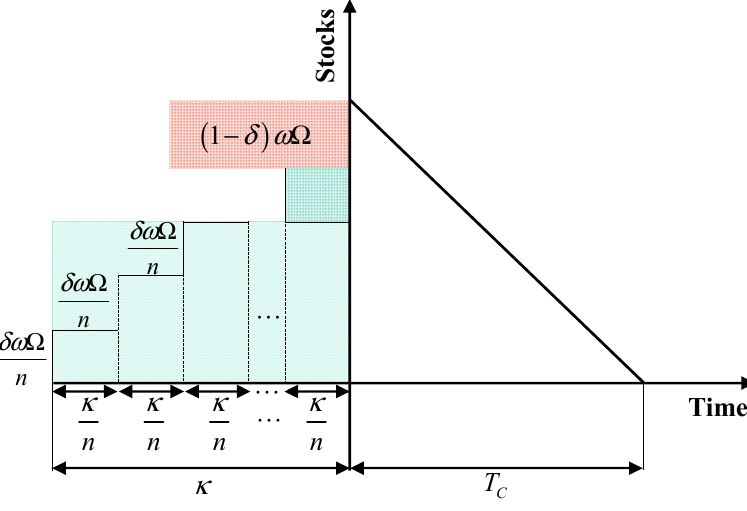
Figure 1. Graphical presentation of the inventory system for Case I.